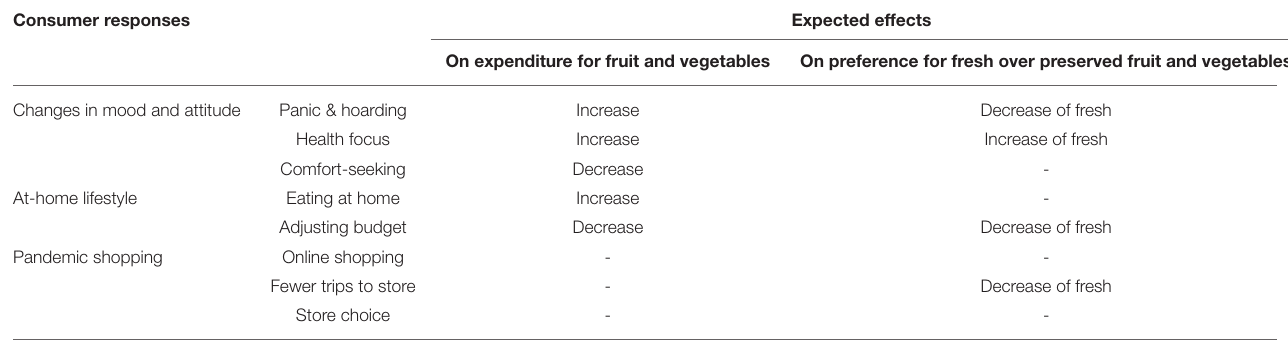
TABLE 1 | Consumer response to COVID-19, their expected effects on expenditure for fruit and vegetables and on the relative preference for fresh products over preserved/processed ones. Consumer